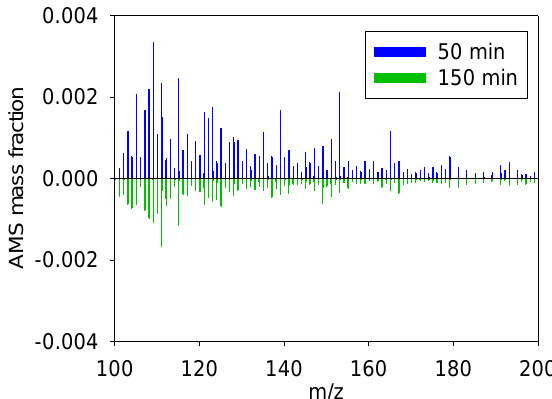
Figure 4. Comparison of HR-ToF-AMS mass spectra (in the range 100–200amu) of the nebulized solutions sampled from experiment B after 50 and 150min of reaction in the aqueous phase. The AMS mass fraction is the signal intensity contribution of each fragment to the total